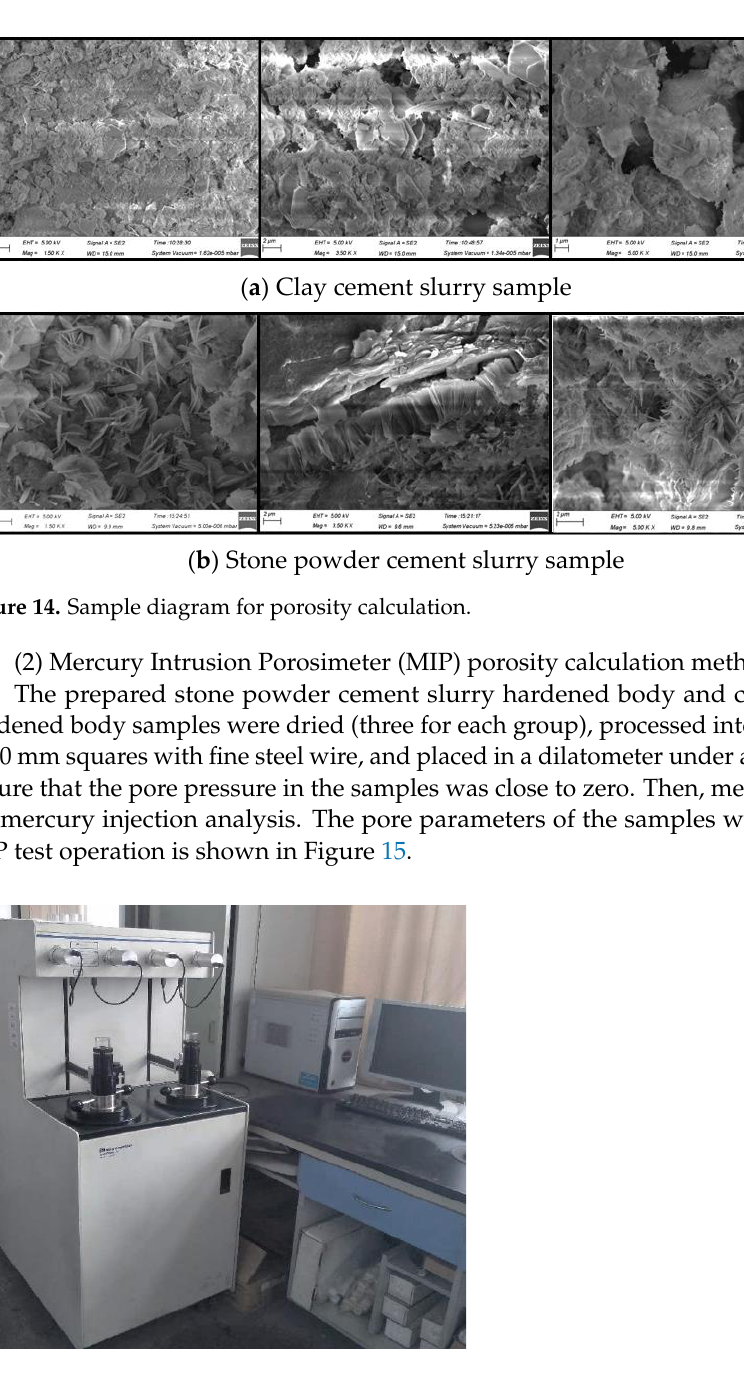
Table 9. Mercury intrusion test parameters.